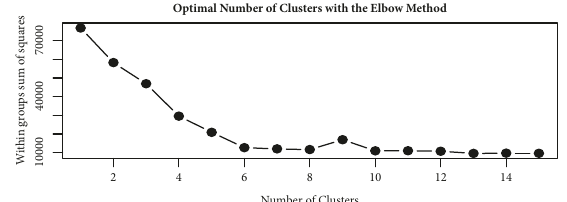
Figure 2: Graph showing six optimal clusters for the Tanzania dataset.